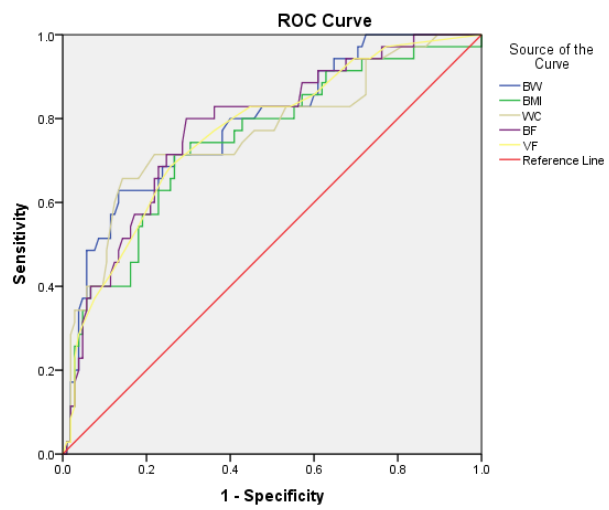
Figure 1. ROC Curve for BW, BMI, WC, BF, and VF as predictors of IR. IR = Insulin Resistance, BW = body weight, BMI = body mass index, WC = waist circumference, BF = body fat percentage, VF = visceral fat level, ROC = receiver operating characteristic curve.